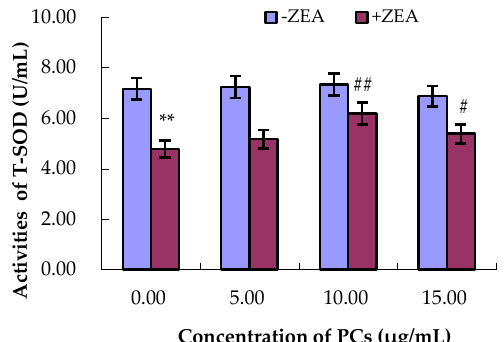
Figure 7. Effects of different concentrations of proanthocyanidins (PCs) on the activities of total superoxide dismutase (T-SOD) exposed to zearalenone (ZEA) (65 µ mol/L). The activities of T-SOD decreased when cells were exposed to ZEA, while the activities of T-SOD did not decrease when cells were treated with PCs. The activities of T-SOD increased when the cells were co-treated with PCs/ZEA. ** p < 0.01 vs. control group; # p < 0.05 and ## p < 0.01 vs. ZEA-treated group.